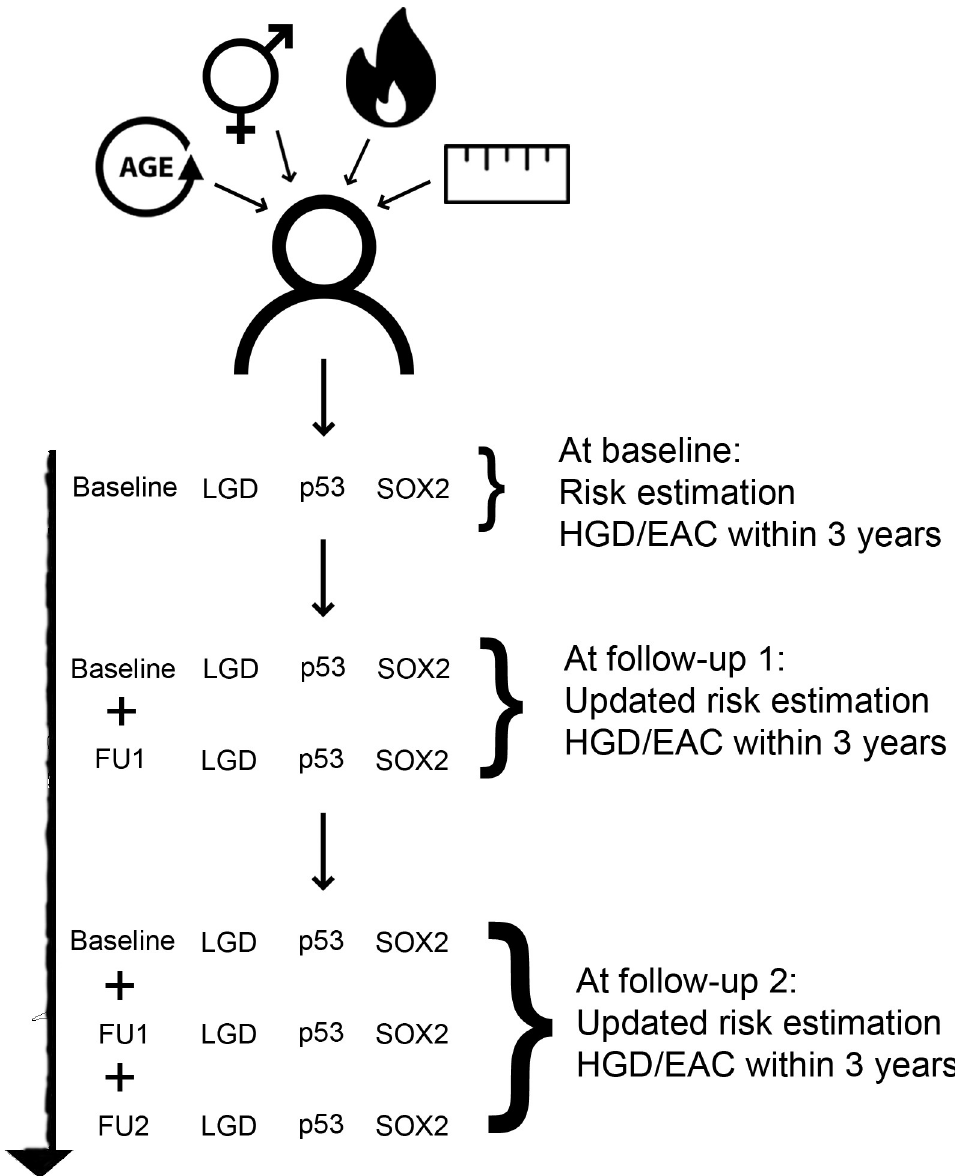
Fig 1. Personalized HGD/EAC risk estimations for a BE surveillance patient, based on age, gender, esophagitis, and BE length. Additionally, at every follow-up markers LGD, p53, and SOX2 are tested, and HGD/EAC risk estimations within three years are updated, based on all measurements of that patient. Based on these dynamic risk estimations the interval can be either shortened, or endoscopic eradication therapy can be applied. BE = Barrett’s esophagus. HGD = high-grade dysplasia. LGD = low-grade dysplasia. EAC = esophageal adenocarcinoma. Predictive performance Optimism-adjusted estimates of the AUC were between 0.80 and 0.88 at different time points, indicating good performance of the model. Since the estimates before adjustment for optimism did not deviate much from those afterwards, there were no signs of overfit- ting (Table 4).